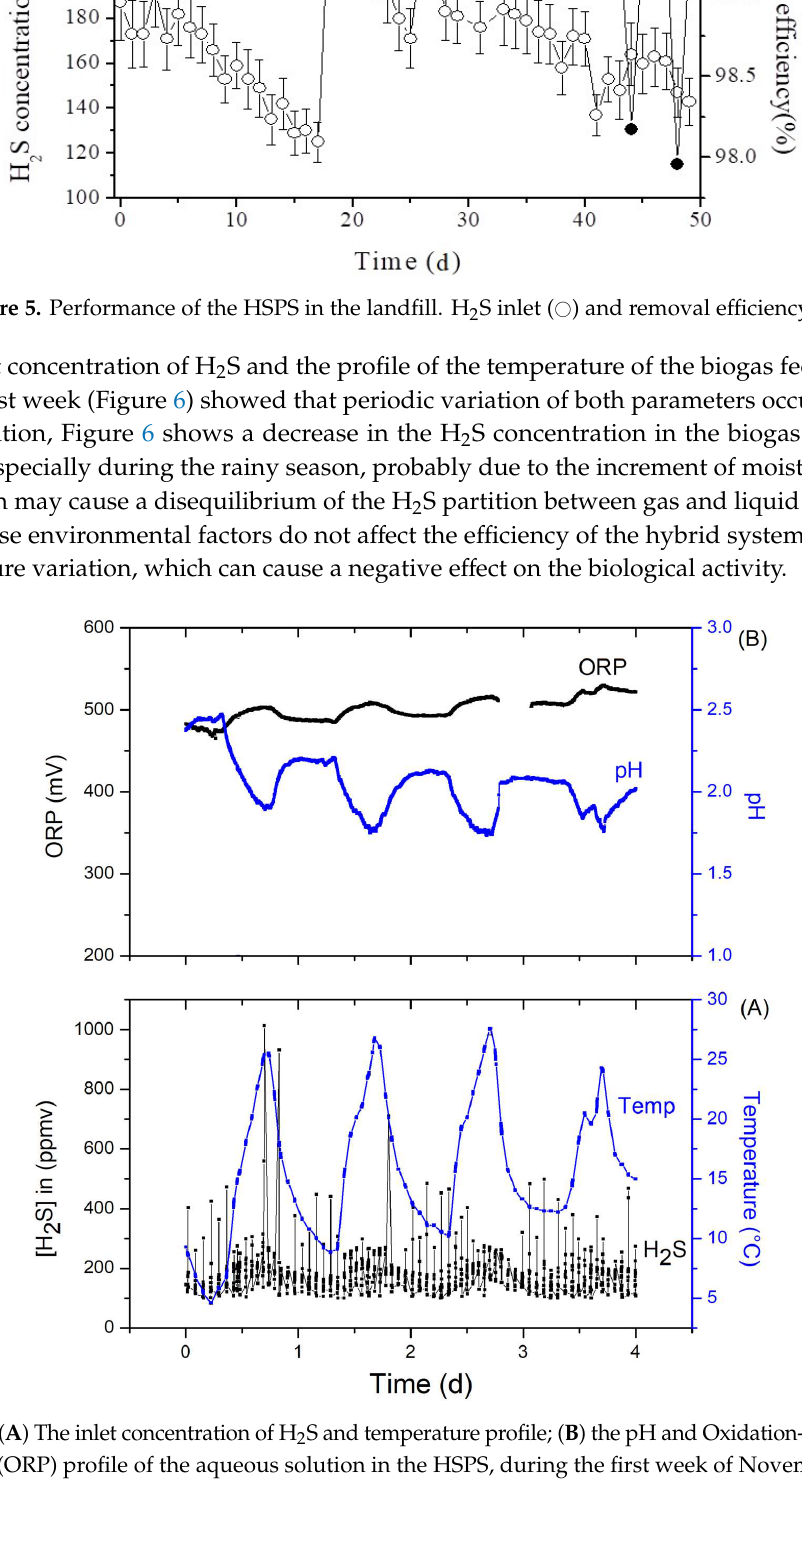
Figure 6. ( A ) The inlet concentration of H 2 S and temperature profile; ( B ) the pH and